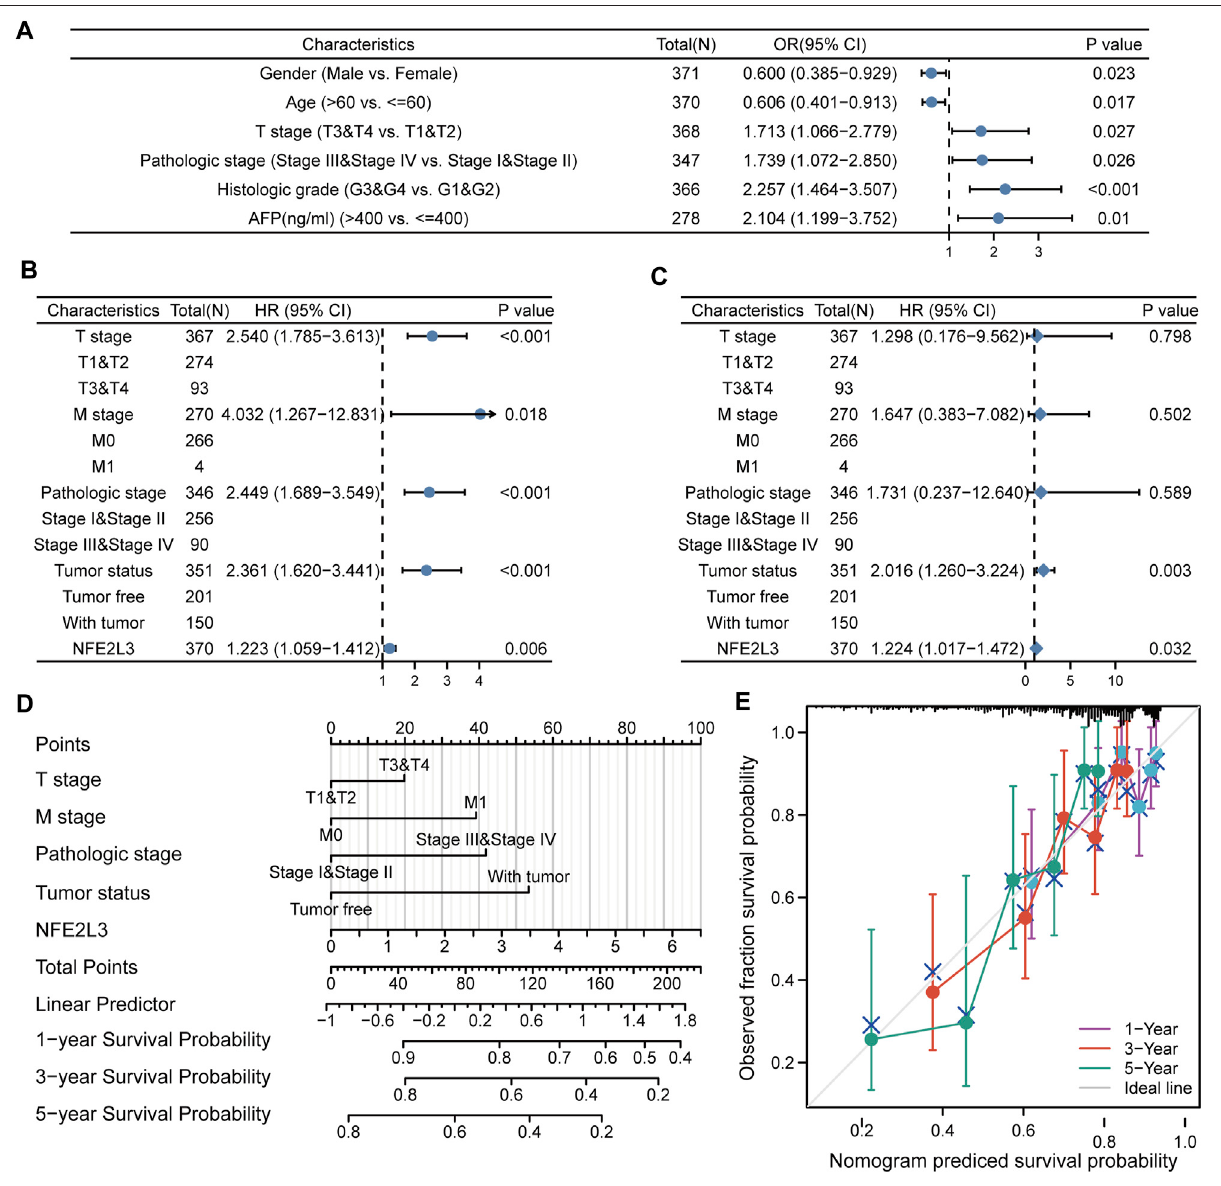
Frontiers in Genetics |